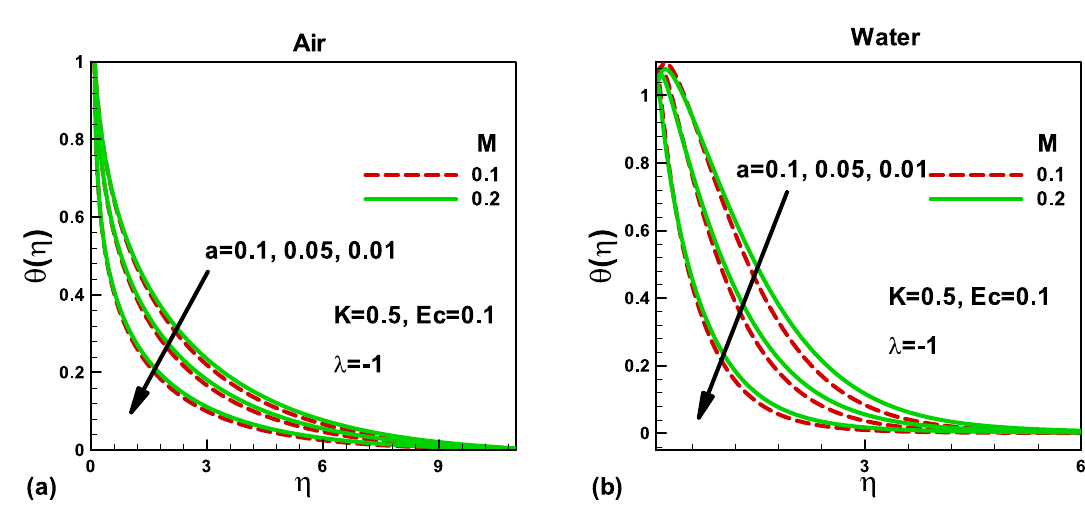
Figure 4. Effects of the magnetic parameter on dimensionless temperature for (a) and (b) when the free stream is moving in the positive x-axis and the needle is moving in the opposite